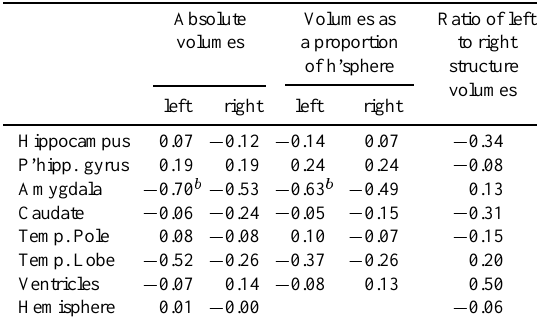
Table 5 Pearson’s product moment correlation coefficient for linear regres- sion analysis of FRM scores against the absolute volume of the hippocampus, amygdala, parahippocampal gyrus, caudate nucleus, temporal pole, lateral ventricles and cerebral hemisphere for the eleven subjects in stage 1 (cid:27)